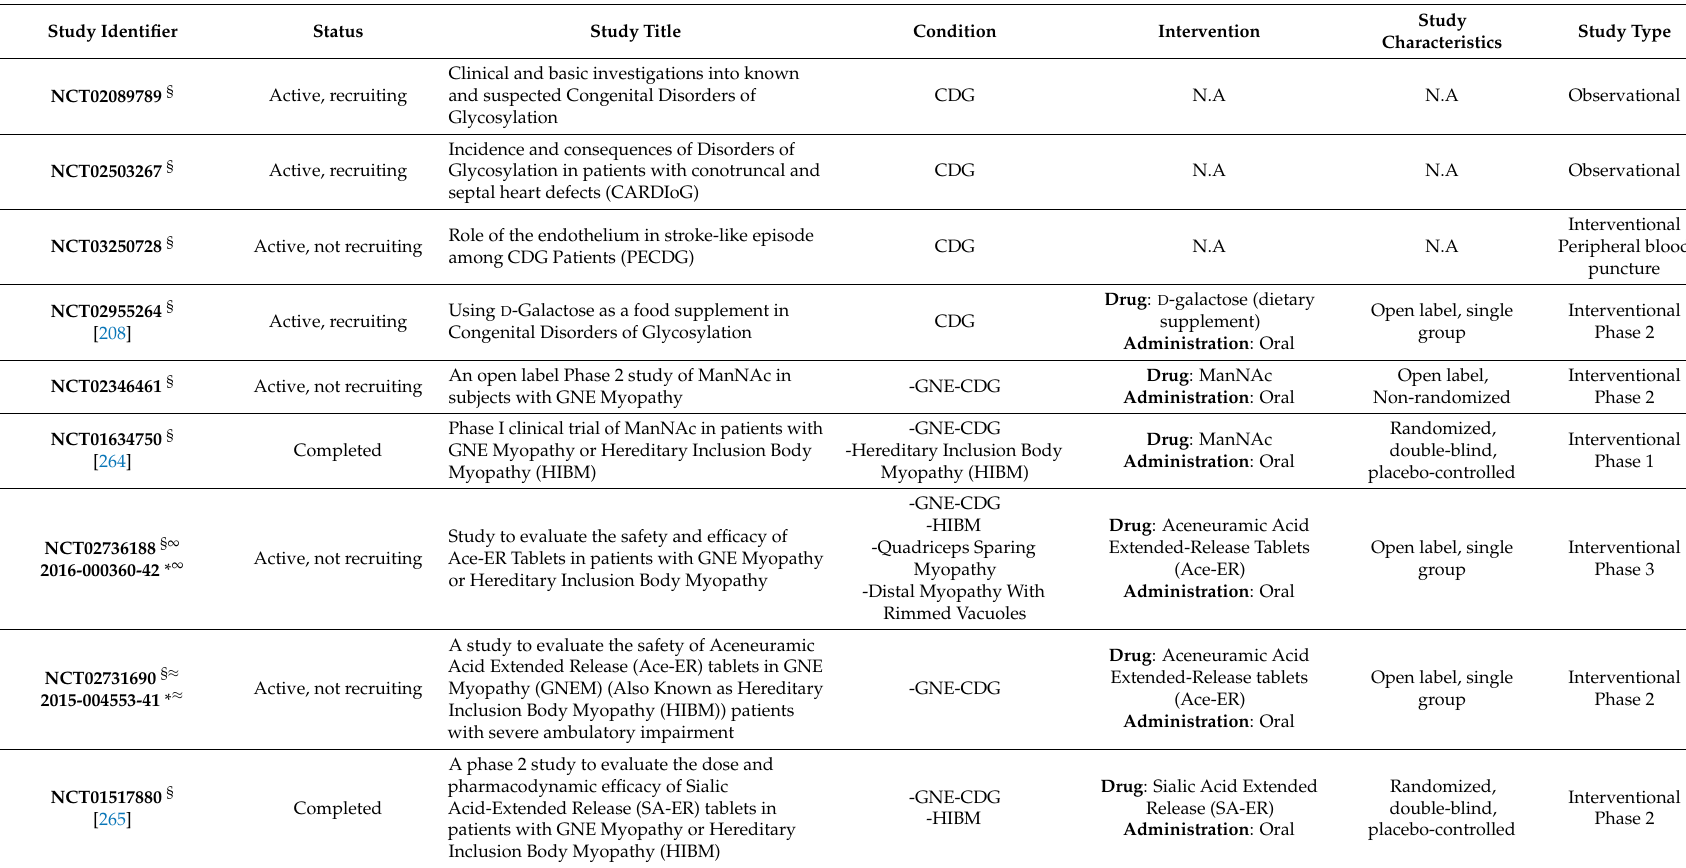
Table 4. Summary of the clinical trials registered at ClinicalTrials.gov and ClinicalTrialsregister.eu, related to Congenital Disorders of Glycosylation. The results were obtained using the following keywords: Congenital Disorders of Glycosylation, GNE, PMM2-CDG and Cerebellar